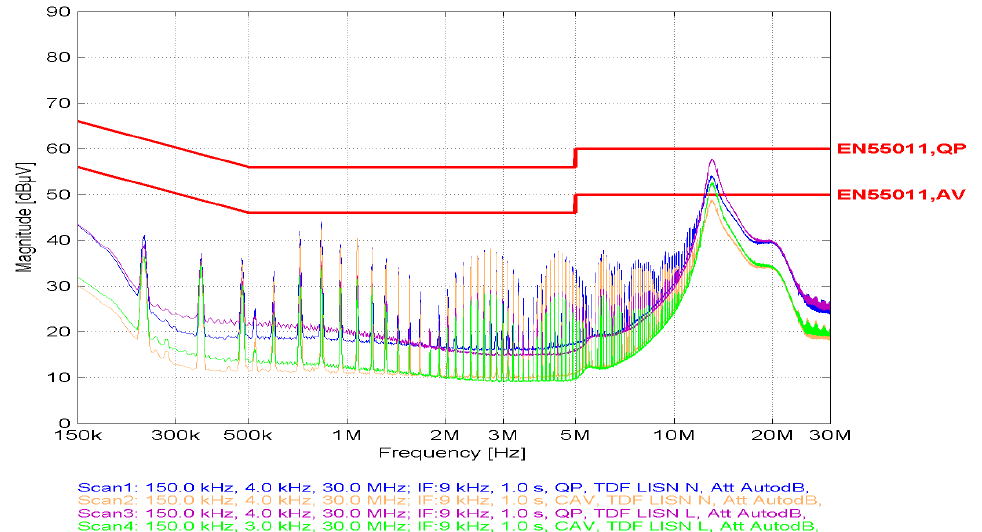
Figure 12. Attenuation level for ferrite No. 2 with the number of coils at 40 pcs. In the next step, tests were carried out to reduce the number of turns to 30 pcs (Figure 13). Even such a reduction in the number of turns provides effective damping and a reserve for further reduction of turns.